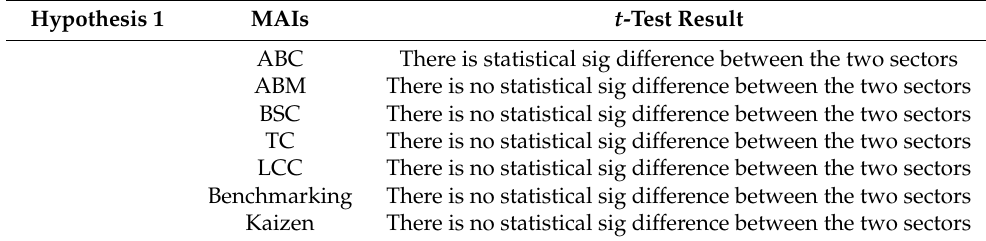
Table 18. t -Test results.